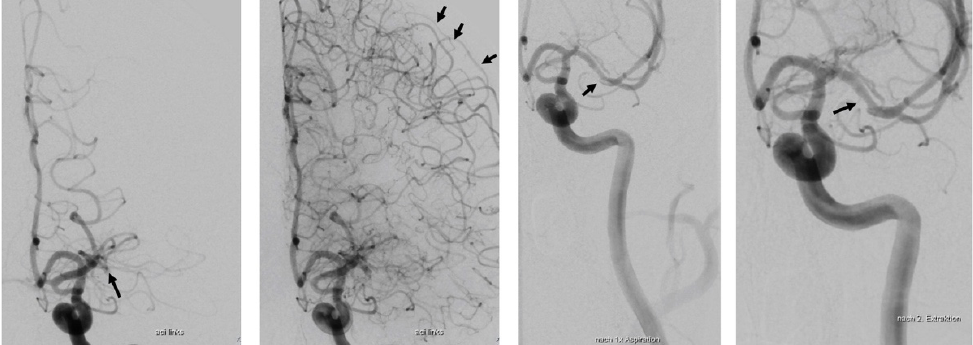
Figure 2. Digital subtraction angiography. Left to right : phase after contrast injection showing proximal MCA occlusion (arrow); demonstration of extensive leptomeningeal collaterals arising from the ACA (arrows); immediately after mechanical thrombectomy by first use of the stent retriever showing suspicious residual thrombus with mild lumen narrowing (arrow) and, right, complete recanalization with mild stenosis/vasospasm (TICI 3).